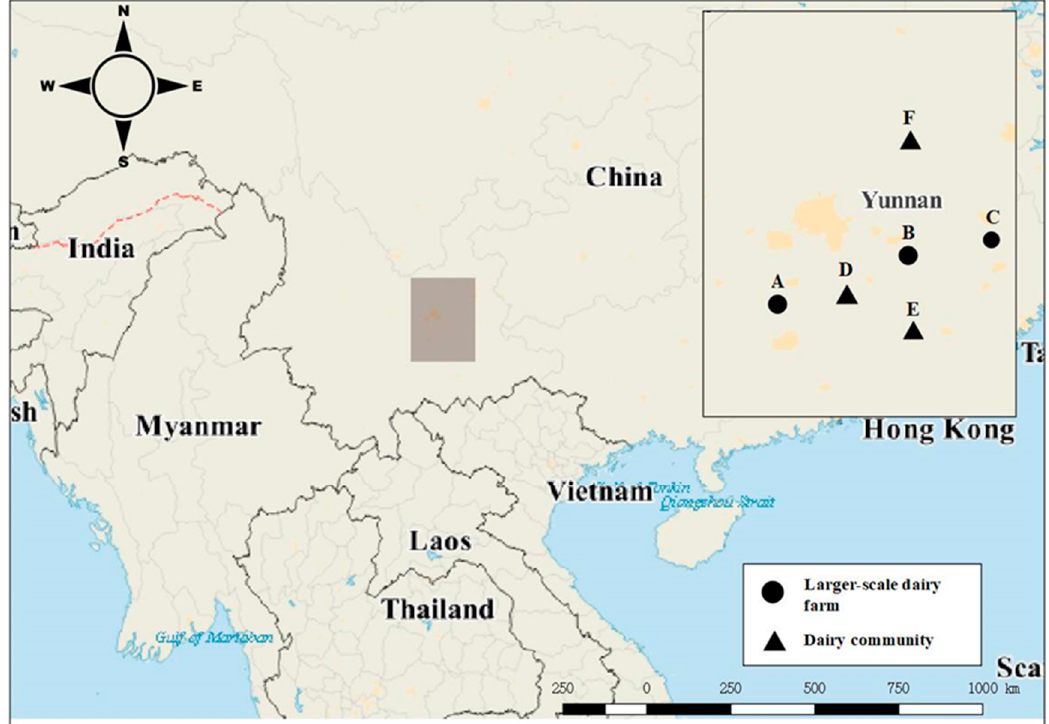
Figure 1. The locations of the farms collected in Yunnan, China. A: Large farm A, B: Large farm B,